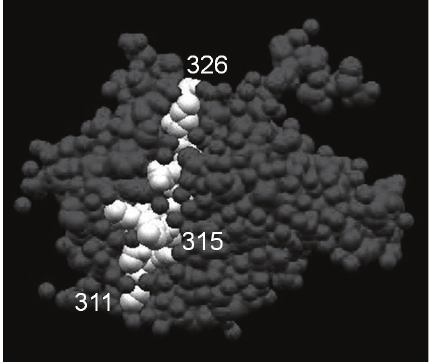
Figure 1: Crystal structure of HSP. GroEL fragment apical domain, a bacterial homologue of human HSP 60, comprising residues 191– 345 derived from Escherichia coli in the Protein Data Bank Japan (PDBj) is shown. Residues 311–326 which corresponded to human HSP60 331–356 are colored with